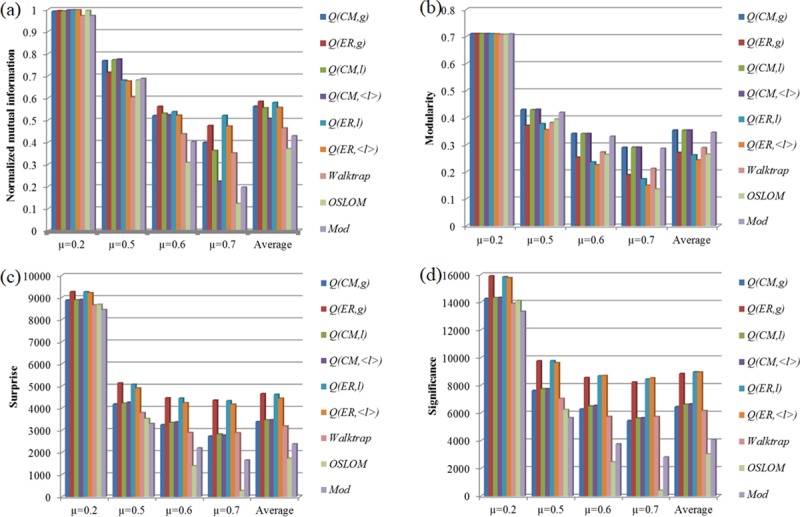
Composite comparison of different methods in the LFR networks with different μ-values.Parameters of networks: N=5000, km=10, kmax=100, cmin=10, and cmax=150 (see Table 1 for details of network parameters). “Mod” denotes the original Modularity. The optimal results is given for the modularity.